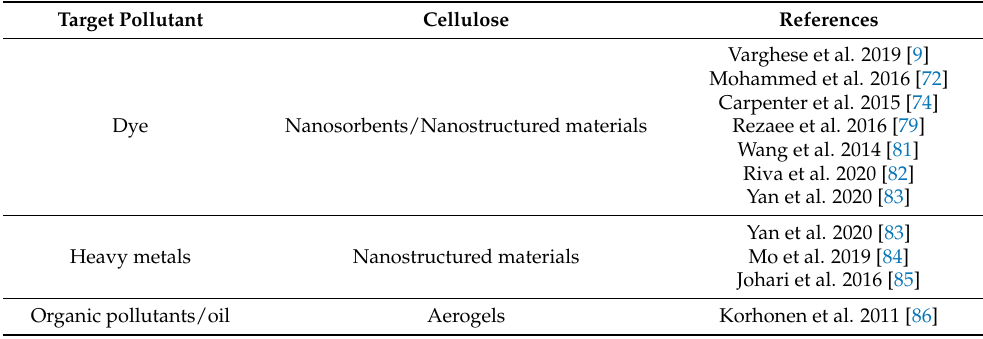
Table 3. Cellulose potential in pollutant